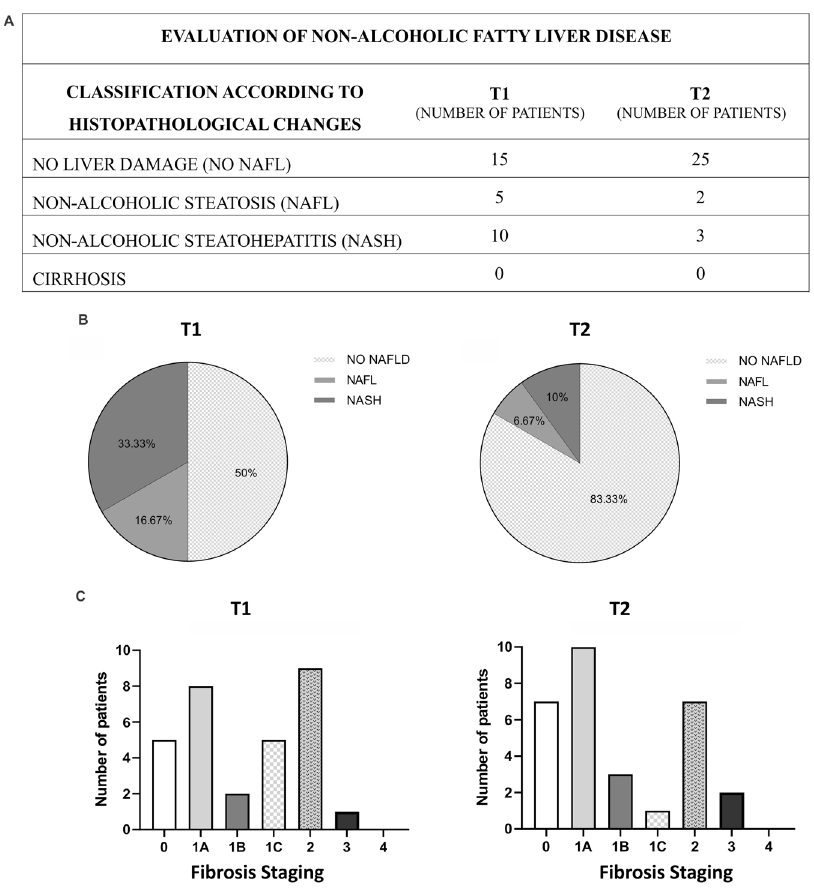
Figure 4. Evaluation of non-alcoholic fatty liver disease at the time of (T1) and after (T2) bariatric surgery. Liver biopsies were performed during the bariatric surgery and also during the second abdominal procedure which the patients were submitted in their follow-up (median of 22 months between surgeries). ( A) Classification of the NAFLD according to histopathological changes of patients before (T1) and after (T2) bariatric surgery (n = 30). ( B) Percentage of T1 and T2 patients that were classified in no liver damage (No NAFLD), non-alcoholic steatosis (NAFL), non-alcoholic steatohepatitis (NASH) and cirrhosis according to histopathological changes. ( C ) Fibrosis staging of T1 and T2 patients according to histopathological